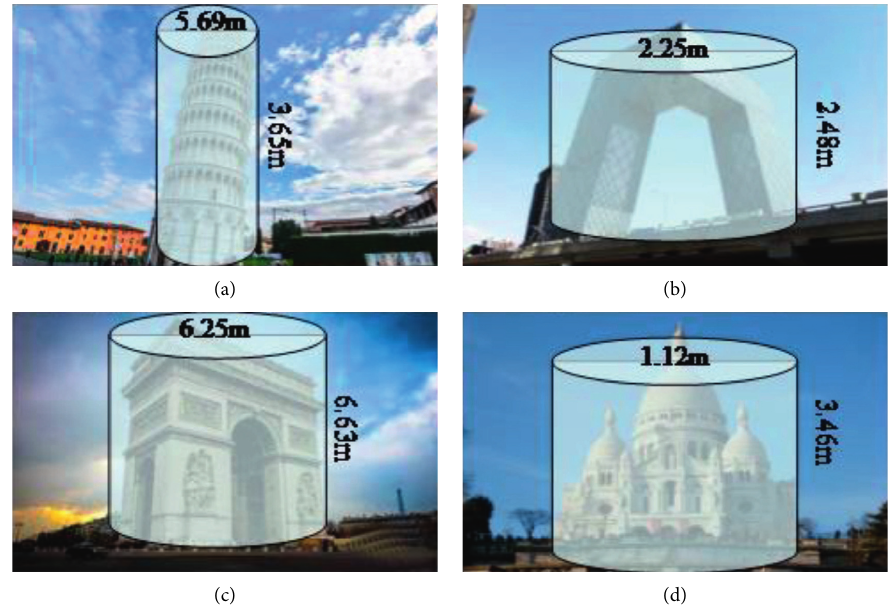
Figure 12: Placement of the cylindrical object in the frustum and the virtual-real registration effect.